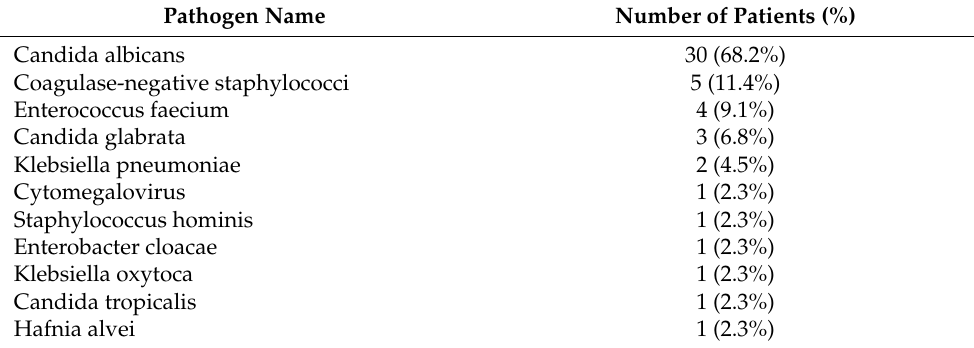
Table 3. Concomitant pathogens detected seven days prior until seven after first HSV occurrence.